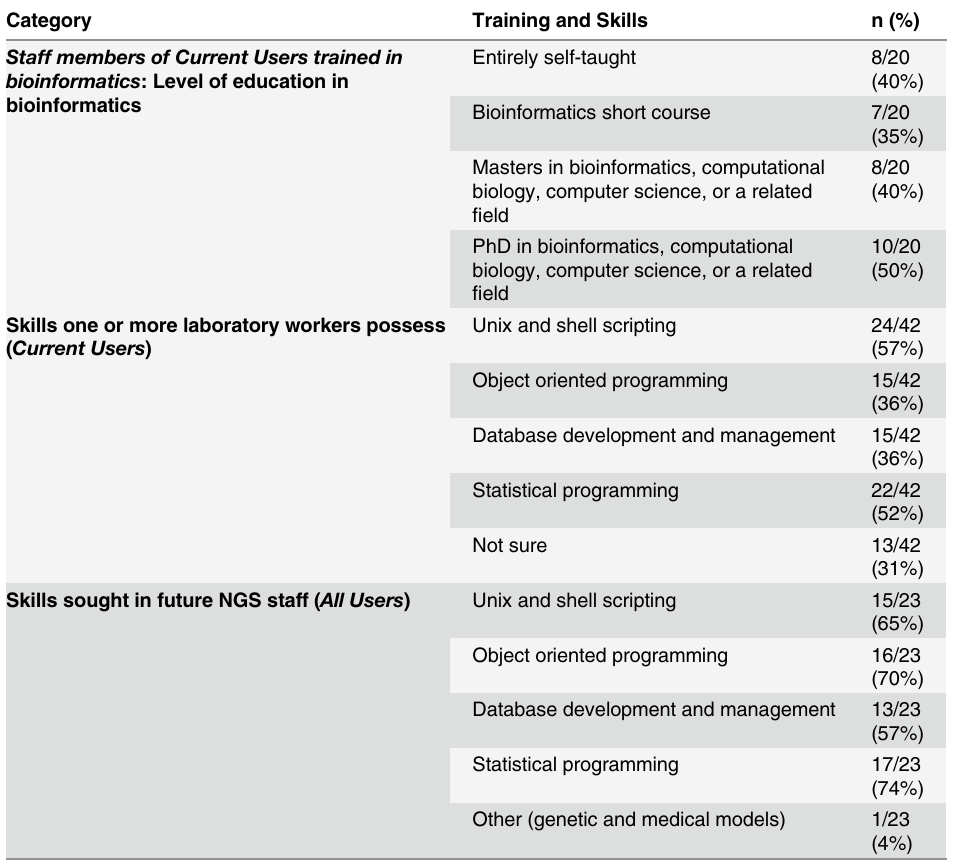
Table 6. Characteristics of Next Generation Sequencing workforce.